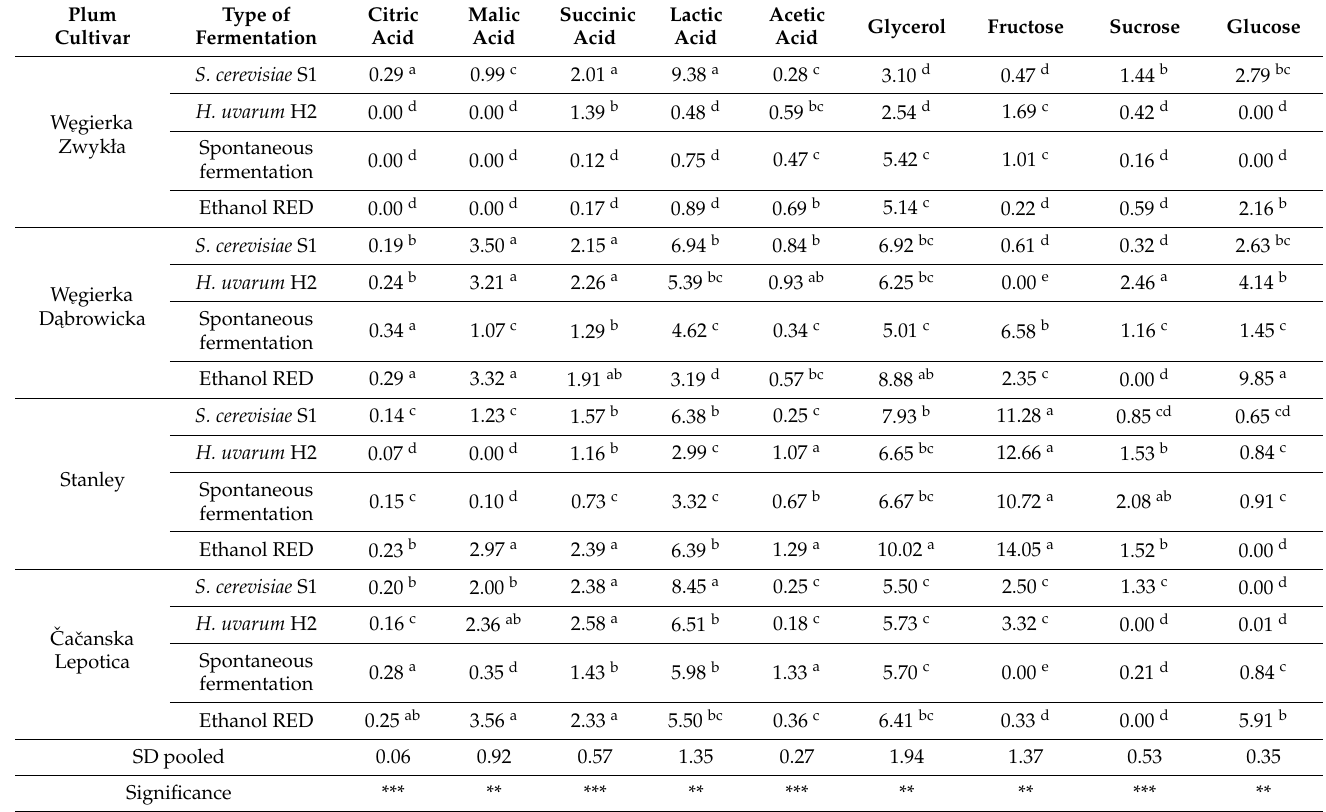
Table 3. Profile of organic acids, sugars, and glycerol concentrations in plum